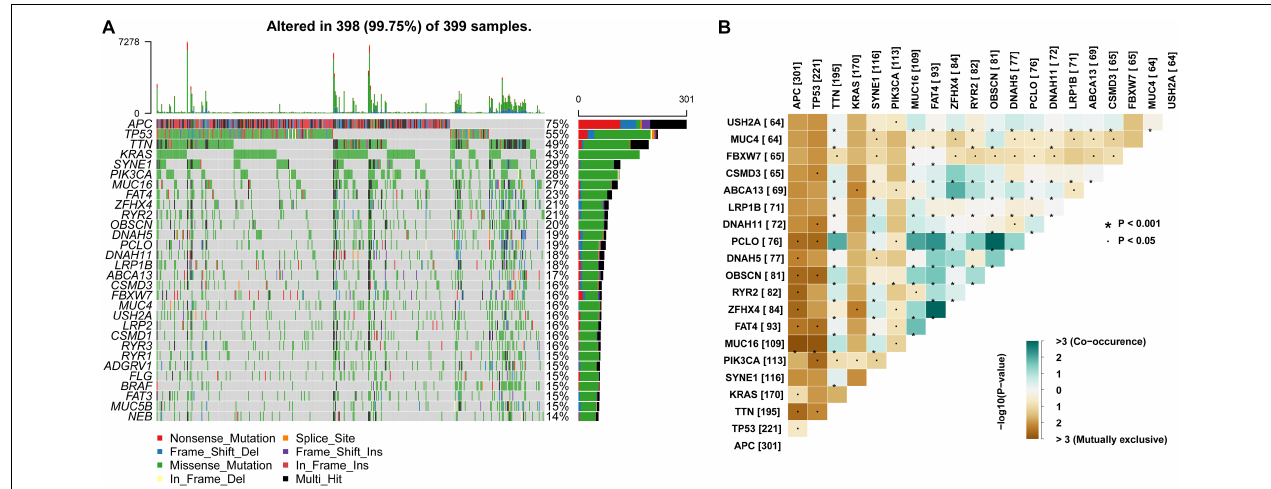
FIGURE 2 | Landscape and potential associations between mutation genes. (A) Waterfall plot showing mutation profiles of each gene in each colon cancer sample. The left panel shows the genes ordered by mutation frequency, which is listed in the right panel. (B) The co-occurrence or exclusive associations between top 20 mutation genes.